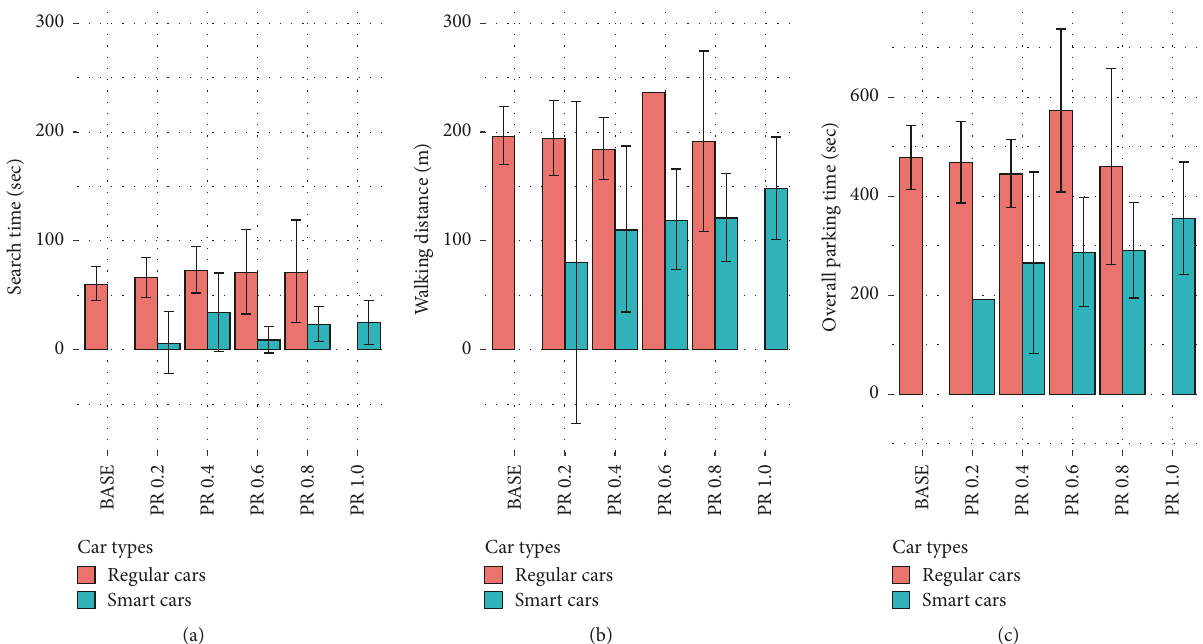
Figure 4: Results for individual drivers for off-street parking: (a) search time, (b) walking distance, and (c) total parking time, for regular cars and smart cars, for a 95% confidence interval at afternoon peak hours.